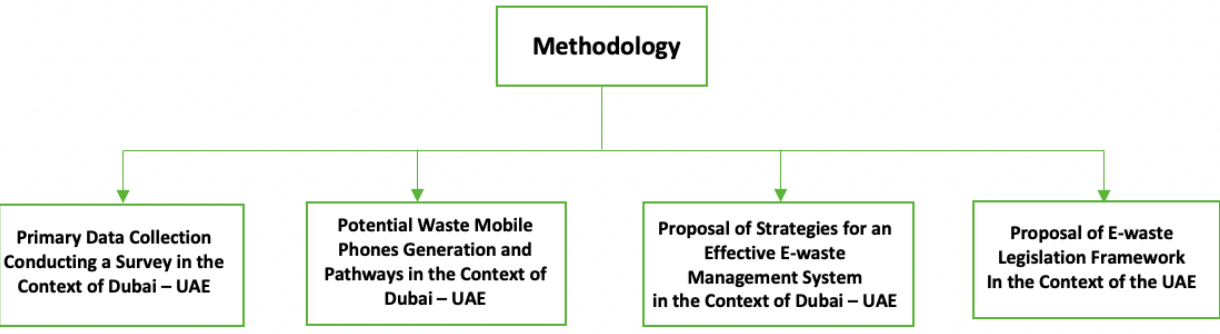
Figure 1. Proposed Methodology Overview.